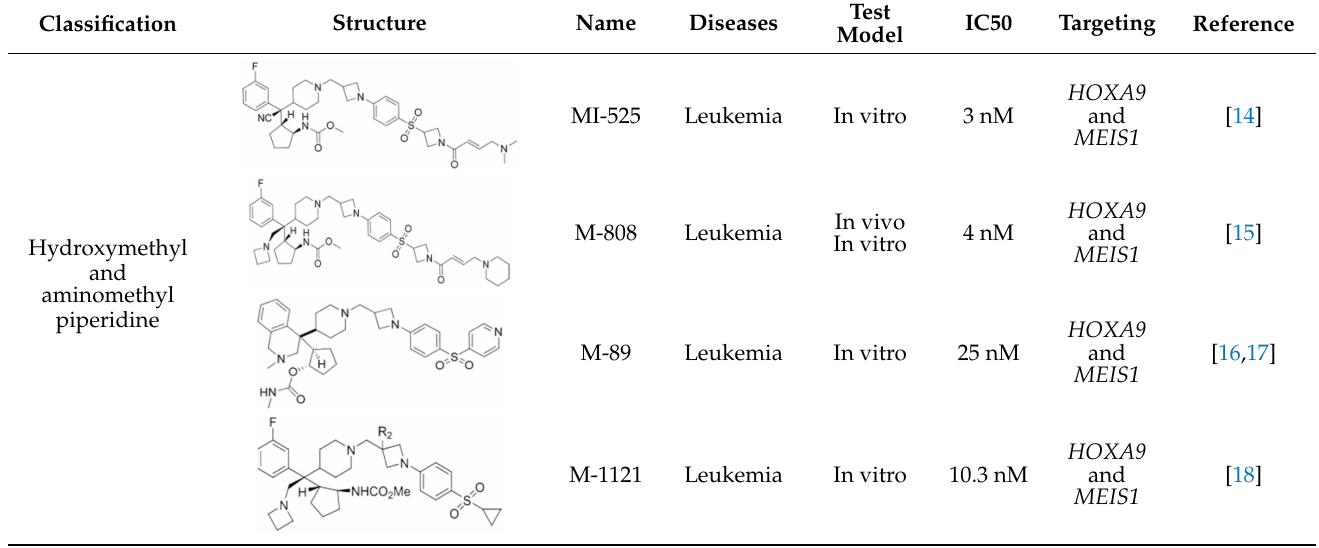
Table 1. Summary of Hydroxymethyl and aminomethyl piperidine inhibitors tested against various